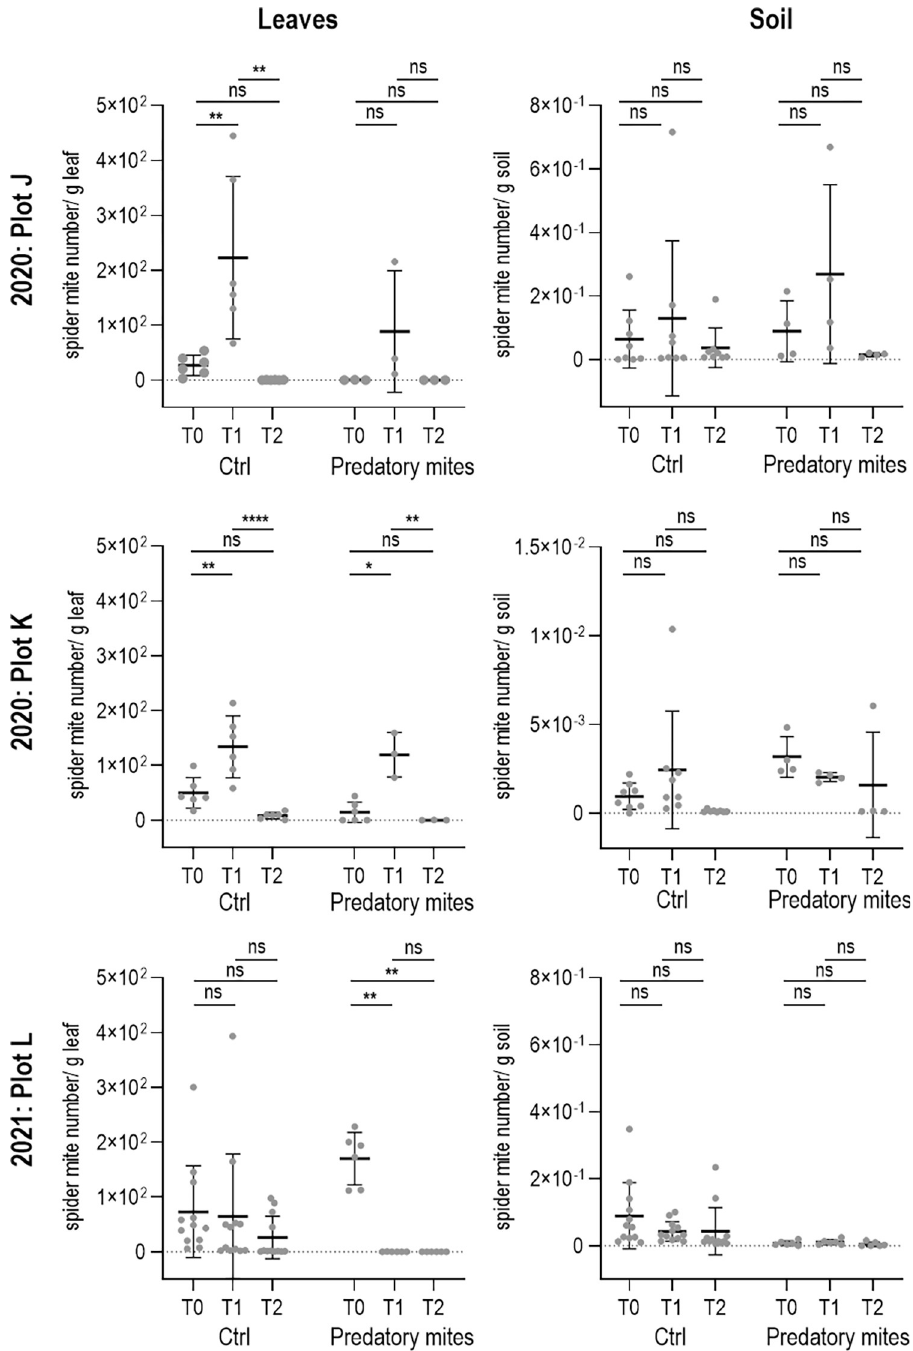
Fig 6. Effect of predatory mites on spider mite hotspots in cucumber cultivation in 2020 and 2021. Soil and leaf samples from spider mite hotspots located in cucumber fields were analysed weekly for three weeks during main cucumber harvest (first sampling time: T0; second sampling time: T1; third sampling time: T2). Untreated control spider mite hotspots (- predatory mites) were compared with hotspots where predatory mites were released (+ predatory mites). Predatory mites ( N . californicus ) were applied between T0 and T1. The control hotspots (-predatory mites) were therefore also colonized with spider mites and represented the natural infestation process without countermeasures. Predatory mites show a reducing effect on spider mites in the hotspot only when the initial level of spider mite colonization is high. Spider mites were detected by HRM real-time PCR. ANOVA was performed with not significant (ns) p > 0.05, and significant correlations at � p � 0.05, �� p � 0.01, ���� p � 0.0001. Shown